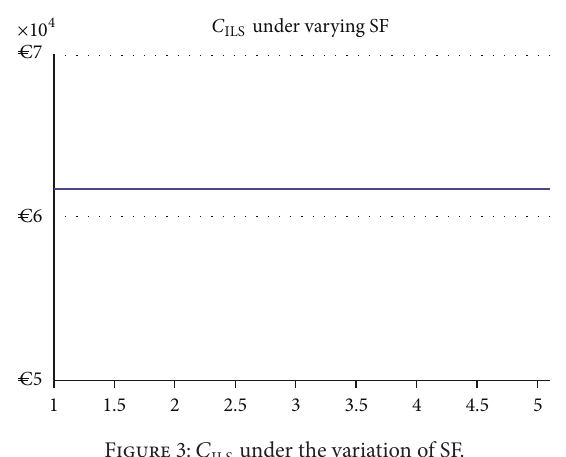
Figure 3: 𝐶 under the variation of ILS